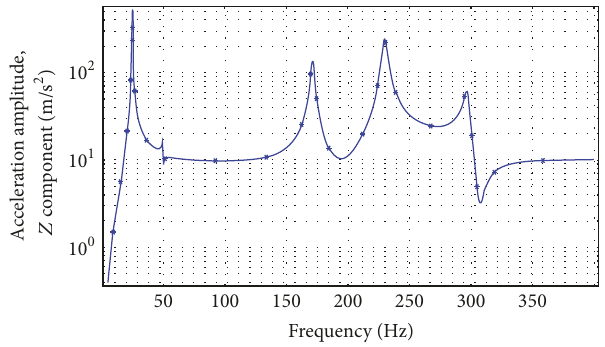
Figure 4: Frequency response characteristics of the harvester.